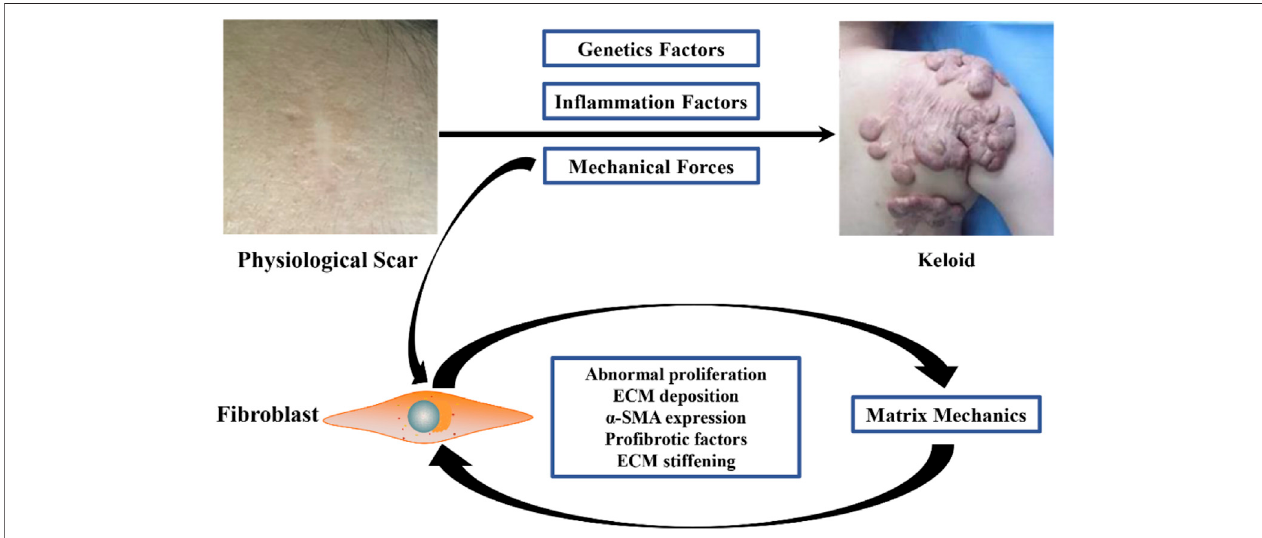
FIGURE1| Causesofkeloidmatrixstiffeningduring fi broticprogression.Mechanicalstimulationcanleadtoexcessiveproliferationofwound fi broblasts,deposition ofECM,secretionofmorepro- fi brosisfactors,andcontinuousincreaseofmatrixstiffnessofkeloidECM.Matrixmechanicsresultingfromelevatedmatrixstiffnessfurther activates the fi brotic phenotype of keloid fi broblasts, thus forming a loop that continuously invades surrounding normal tissue.